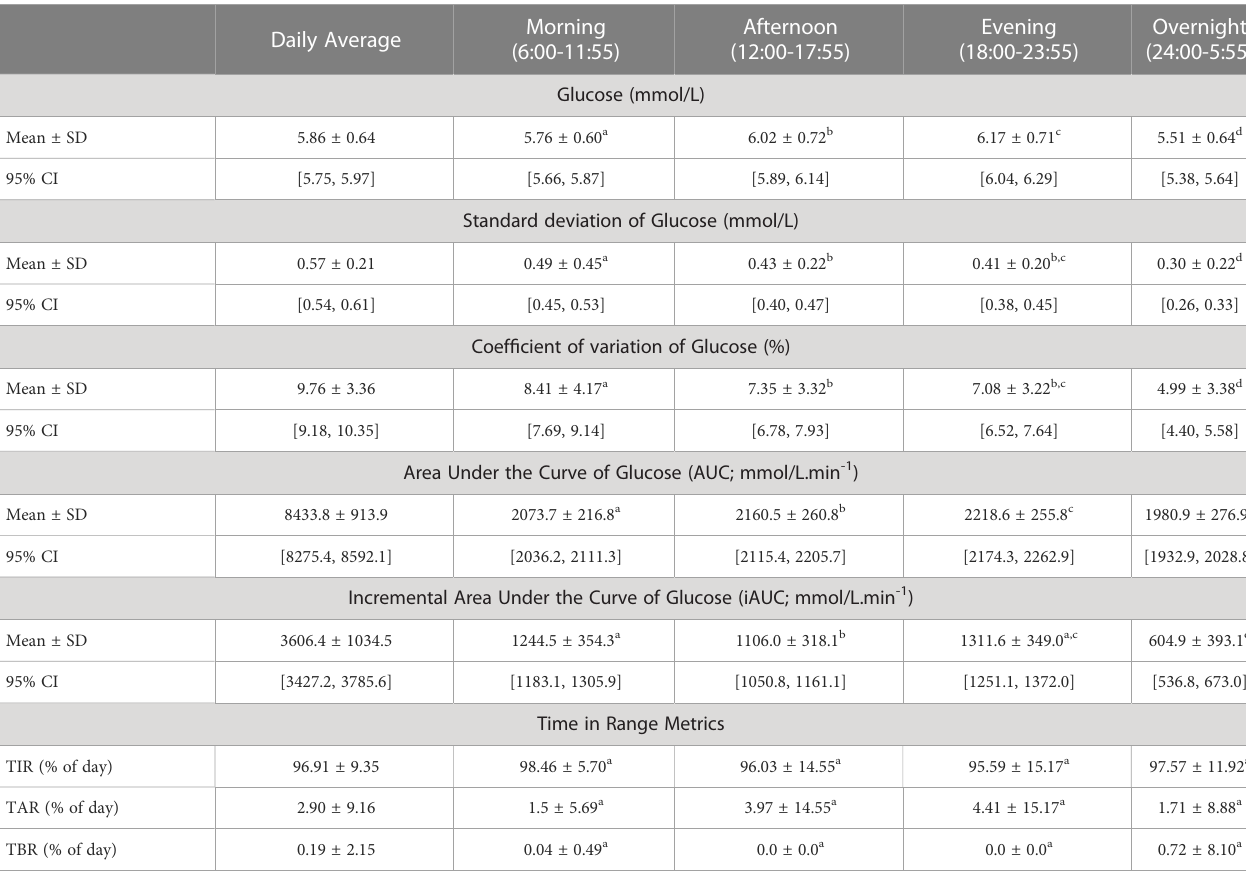
TABLE 2 Summary of measures of continuous glucose monitoring CGM over a 24-hour period.